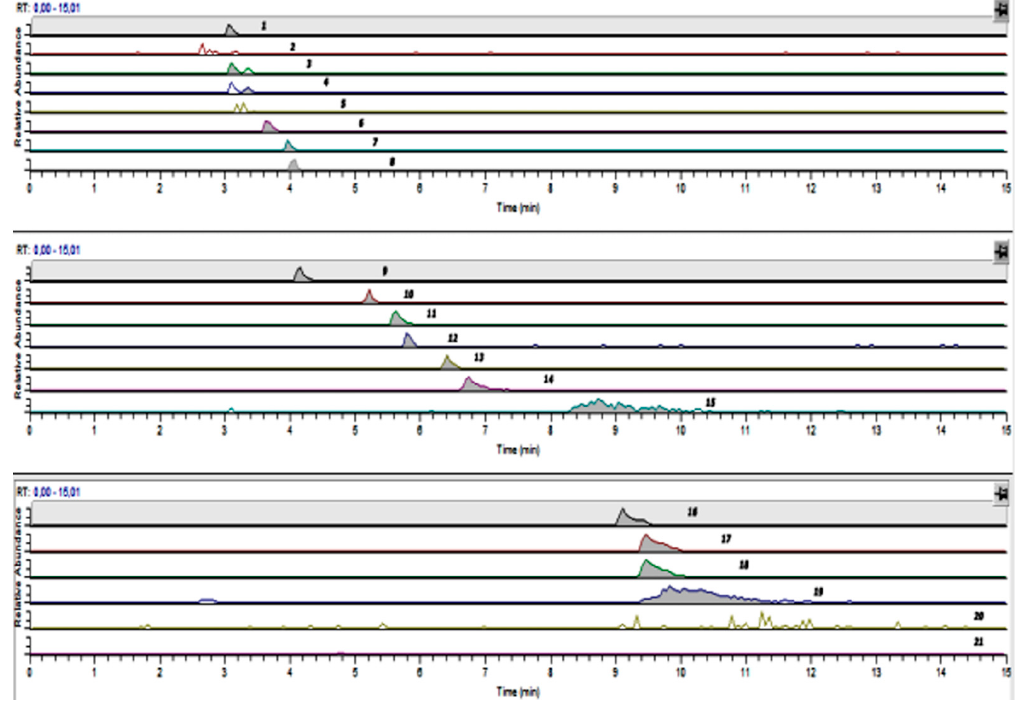
Figure 1. HILIC UHPLC–MS / MS chromatographic traces of the 17 amino acids quantified in the